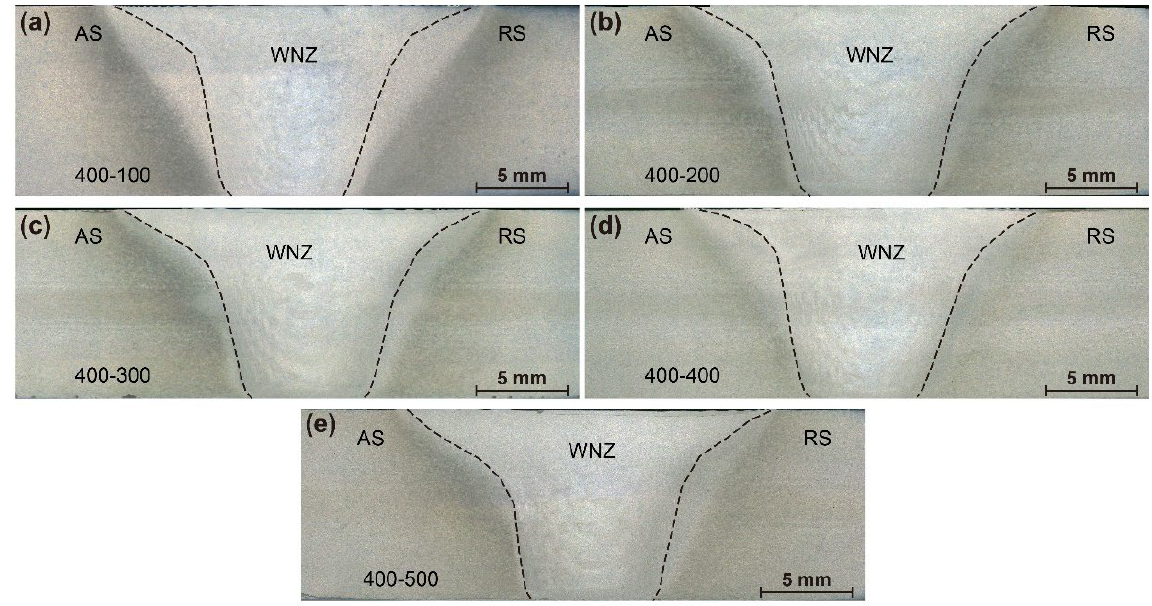
Figure 8. Macrostructure of joints by Pin-2 ( a ) 100 mm/min, ( b ) 200 mm/min, ( c ) 300 mm/min, ( d ) 400 mm/min, and ( e ) 500 mm/min.